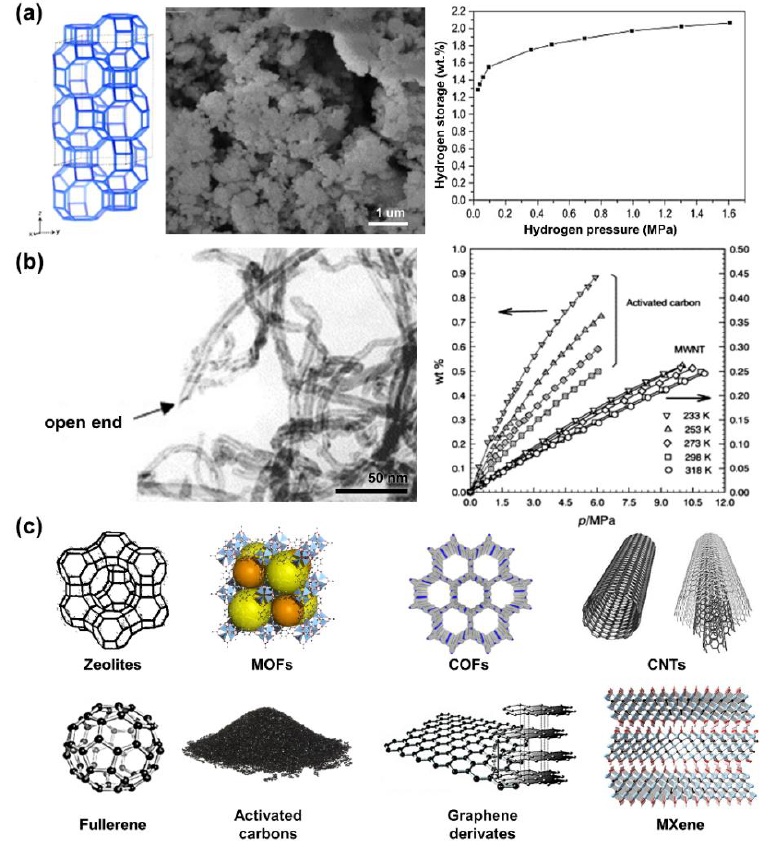
Figure 3. ( a ) Three-dimensional structural information, SEM image, and hydrogen uptake on 77 K and 16 bar of LEV-type zeolite for hydrogen adsorption, ( b ) TEM image and hydrogen storage uptakes on various temperatures (233–318 K) and 110 bar, and ( c ) various candidates for hydrogen adsorbents. Reproduced from ref. [60]; copyright (2007) with permission from Elsevier. Reproduced from ref. [61]; copyright (2004) with permission from Nature